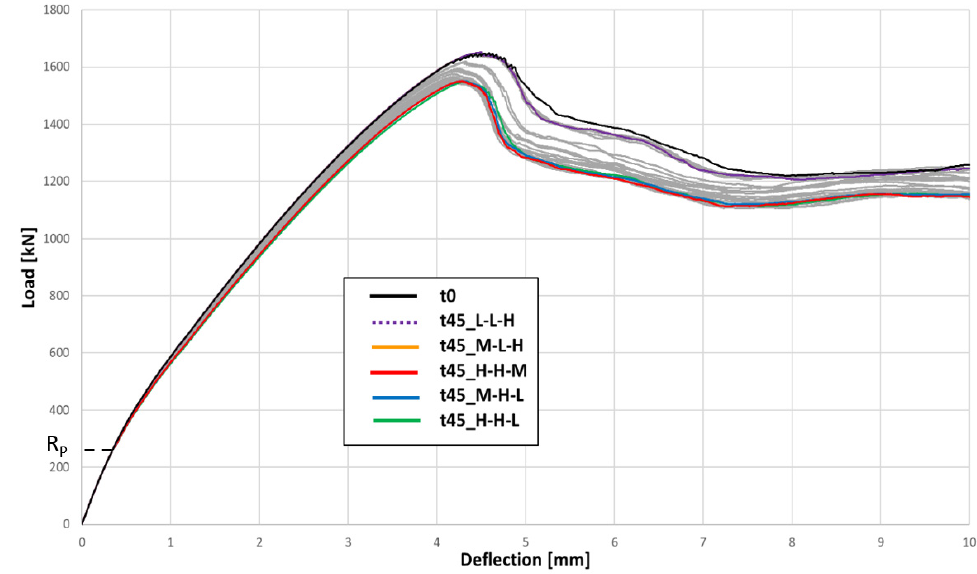
Figure 18. Envelope of load-deflection curves of chloride-induced corrosion analyses at 45 years.